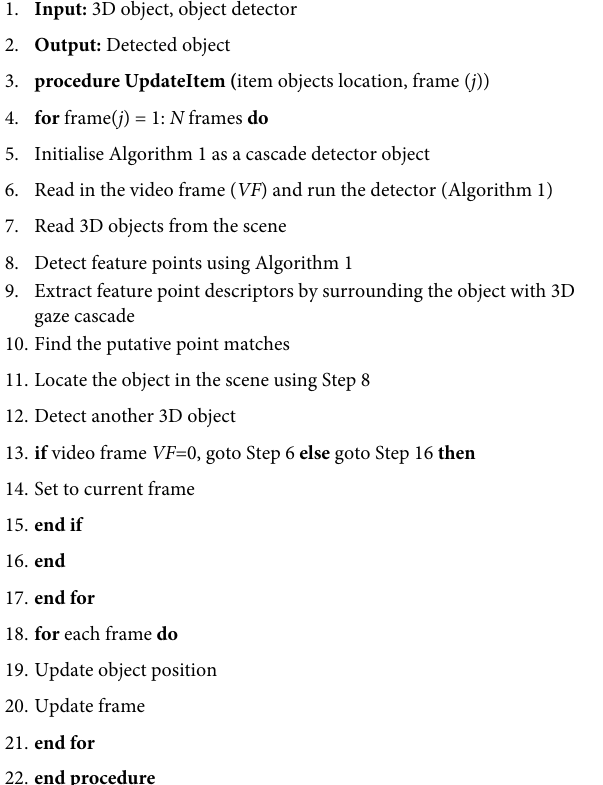
Algorithm 2 3D object detection on a 3D video game